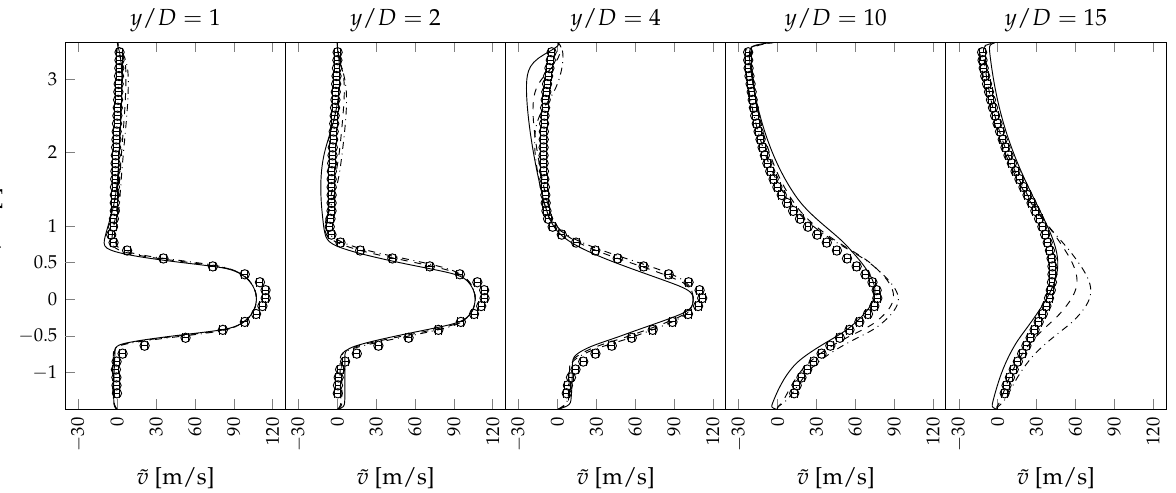
Figure 10. Mean axial velocity profiles plots at various stream-wise locations. FGM-NAC ( ), FGM-NA ( ), FGM-A ( ), Raman measurement results ( ) [2].